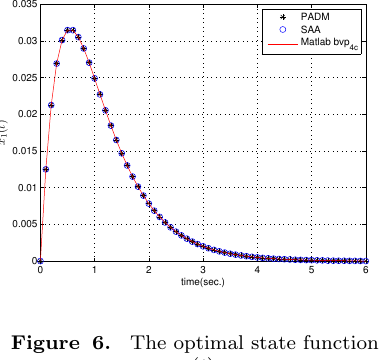
Figure 6. The optimal state function x 1 ( t ).